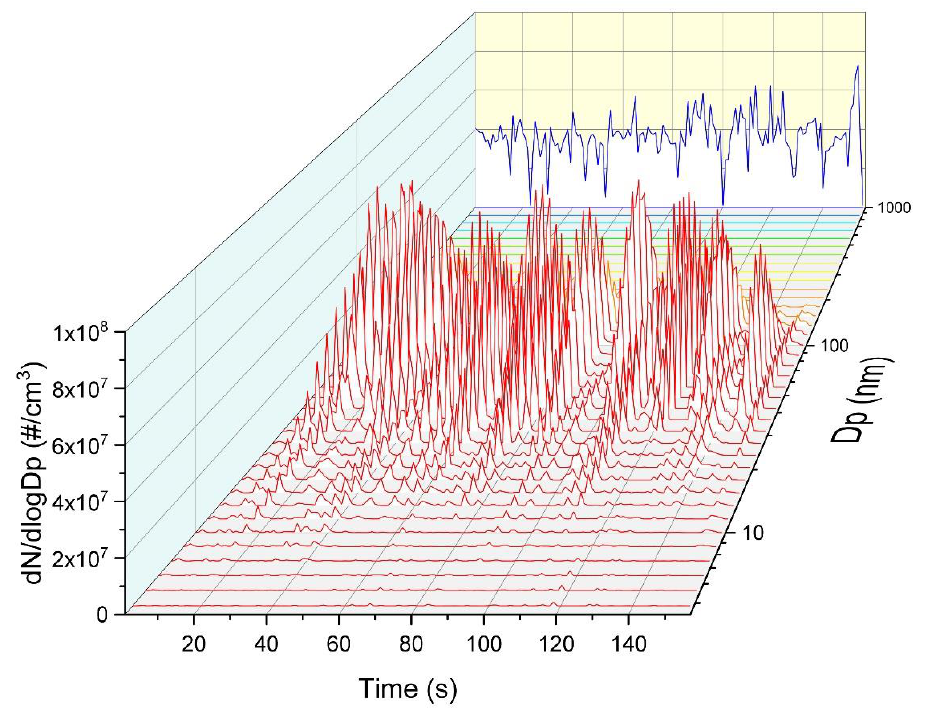
Figure 12. Example of one RDE test PNSD with time for all engine re-ignition events. Engine RPM is indicated in blue at 3 × 10 4 times scale.